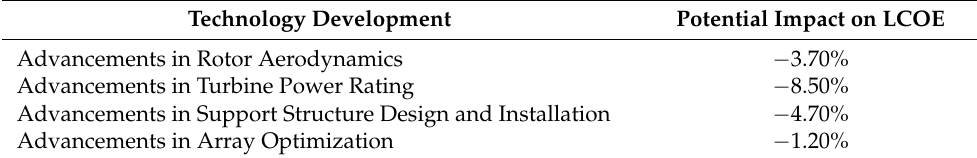
Table 1. Impact of technological development on offshore wind turbines [9]. Technology Development Potential Impact on LCOE Advancements in Rotor Aerodynamics − 3.70% Advancements in Turbine Power Rating − 8.50% Advancements in Support Structure Design and Installation − 4.70% Advancements in Array